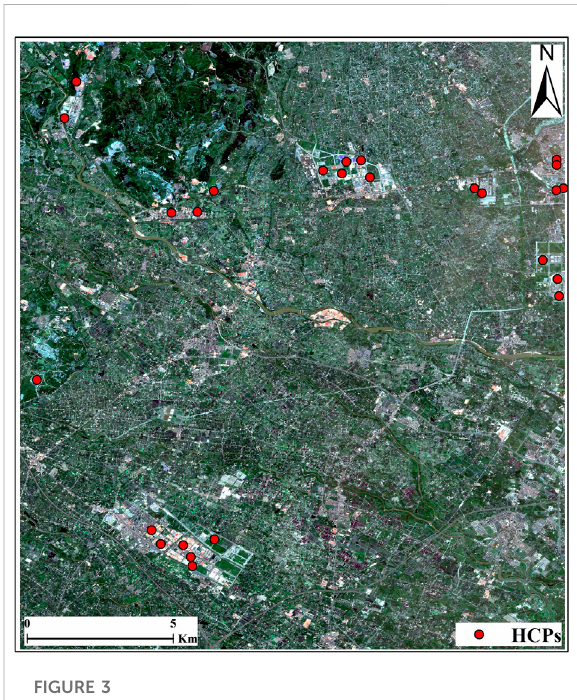
FIGURE 3 Distribution of ground highly coherent points (HCPs) in the study area. The background is 10-m resolution Sentinel-2 true- color